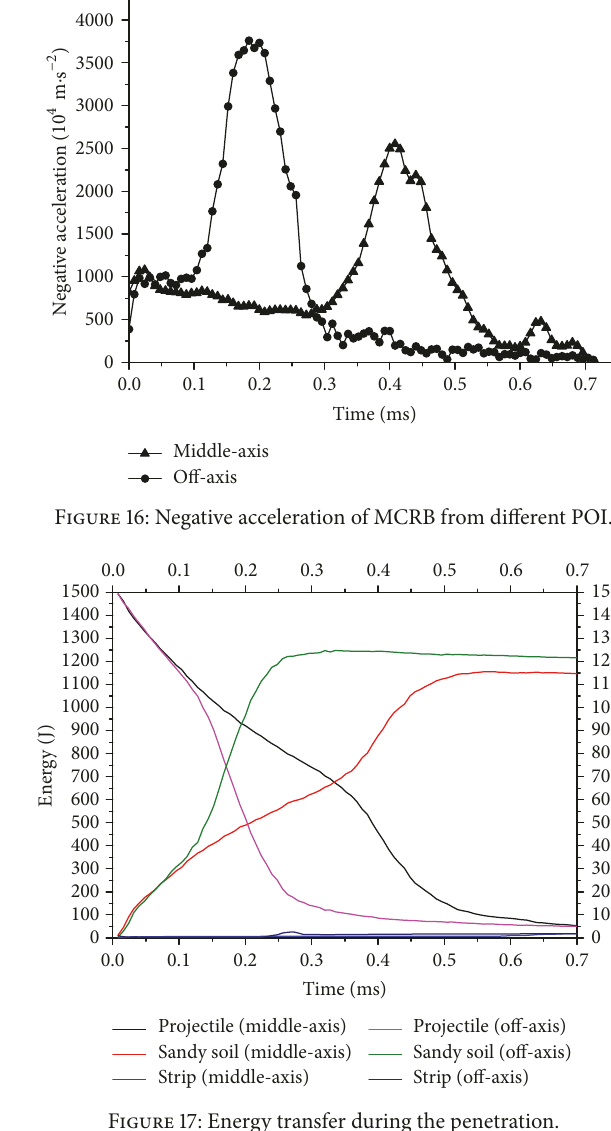
Figure 14: Penetration from middle-axis by MCRB.